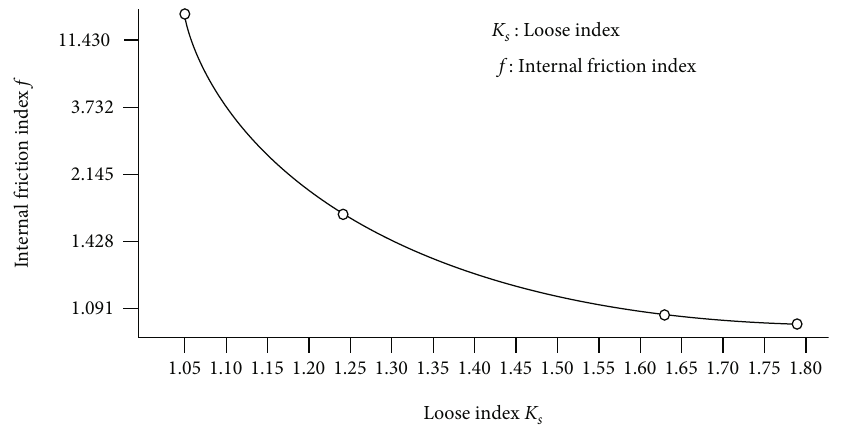
Figure 3: Correspondence between internal friction index and loose index